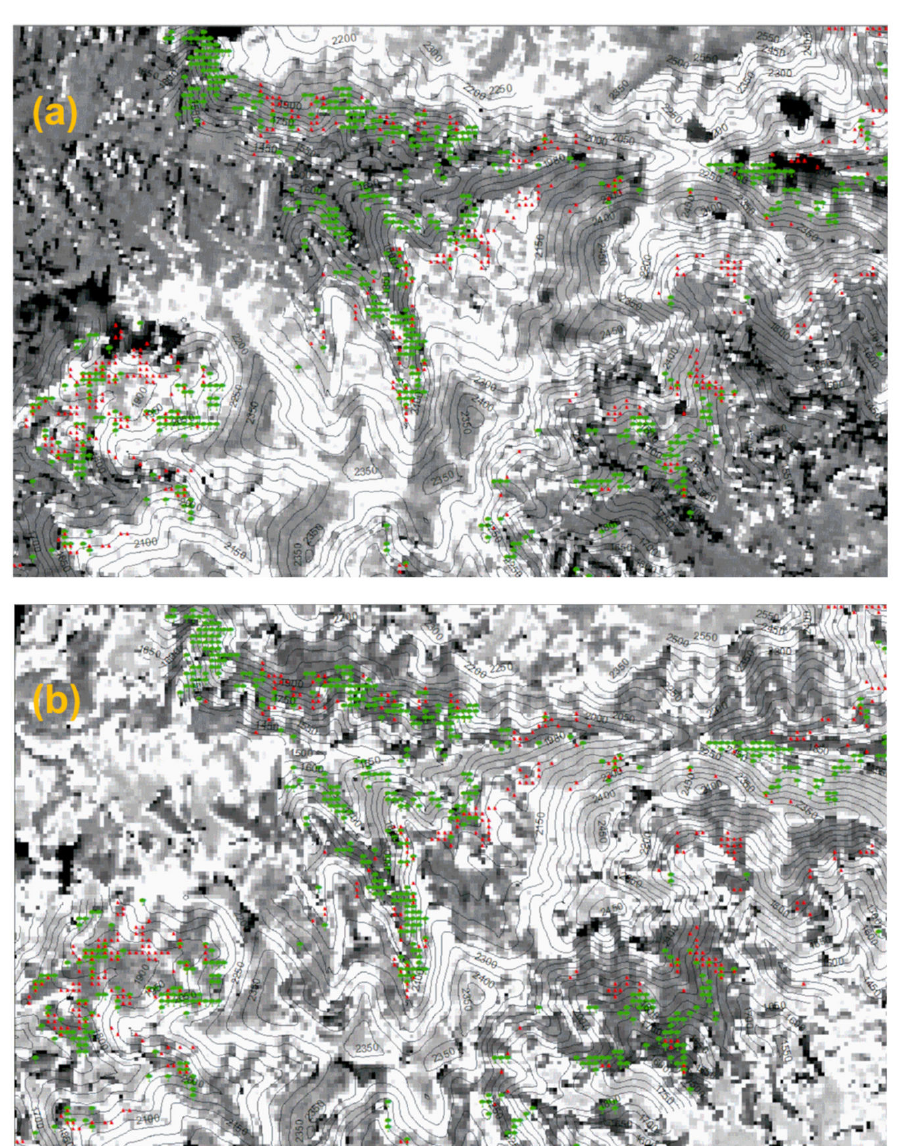
Figure 10. Data reanalysis: Spatial patterns of change in species composition at locations with known long-term modifications. Copernicus HRL change in tree cover density (red pixel centroids represent increase in coniferous and green pixel centroids represent increase in the broadleaved tree cover density between the base years 2015 and 2018 at 100 m pixel) is the baseline to locate changes in NDGI values for earlier periods: ( a ) 07.1987 to 07.1990; ( b ) 06.1985 to 06.1994. Similar values of NDGI correspond to similar changes in vegetation growth intensity between the pairs of years used to generate NDGI. A comparison between the two NDGI TMs and the HRL spatial overlay suggests that active change in tree species composition started around 1990. The higher precipitation in June 1985 strengthens the baseline signal and therefore accounts for smaller differences found in NDGI and vegetation growth in the second